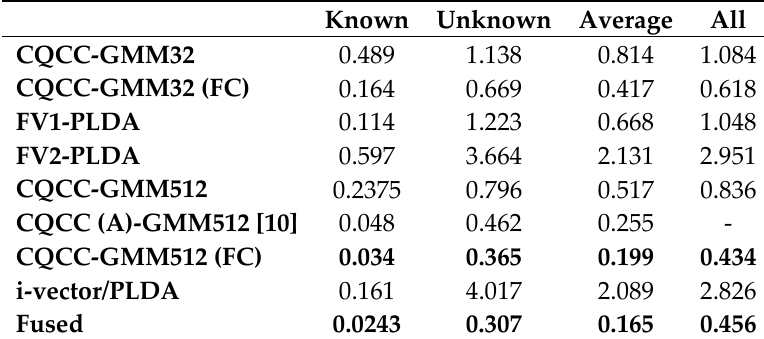
Table 3. Spoofing detection performance (in terms of EER) of all systems considered herein, including the Fisher vectors-based systems on the ASVspoof2015 evaluation set. Results are reported on the Known (average of S1–S5), Unknown (average of S6–S10), Average (average of S1–S10), and All conditions (using a single decision threshold) as described in Section 5.3. The lowest EERs are highlighted in bold face. In [10], the performance of CQCC (A)-GMM512 was not reported on the All evaluation condition, and therefore, we were not able to compare it in this